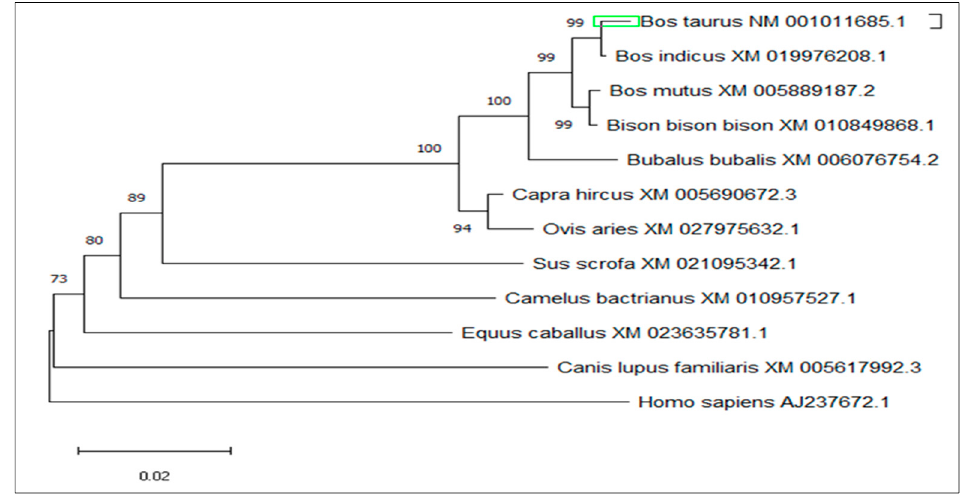
Figure 4. Phylogenetic tree of MTHFR among closely related species.